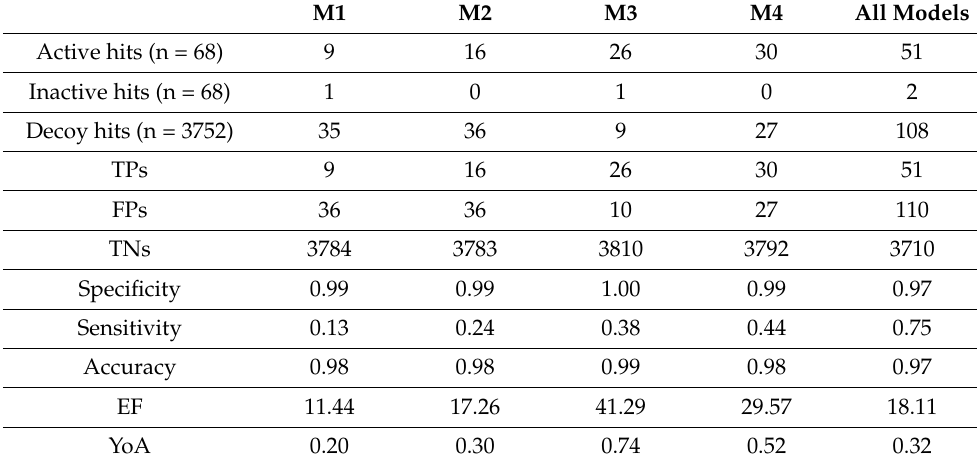
Table 1. Theoretical evaluation of the generated pharmacophore models. The models were evaluated and compared to each other regarding model accuracy, enrichment factor (EF), and yield of actives (YoA). TPs, true positives. FPs, false positives. TNs, true negatives. M1 M2 M3 M4 All